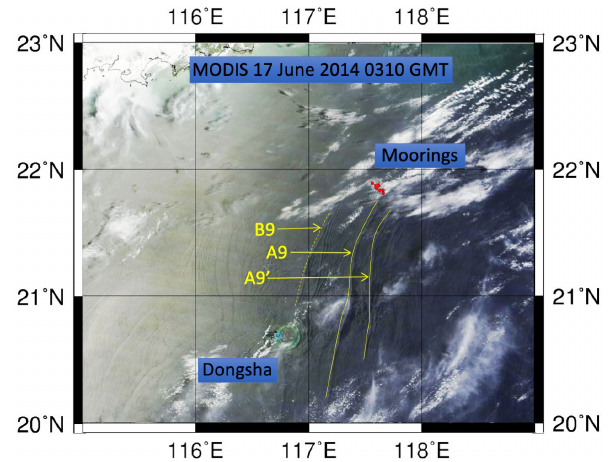
Figure 9. A sea surface ocean color image obtained at 03:10 on 17 June 2014 from the Moderate Resolution Imaging Spectrora- diometer (MODIS). The sand dunes moorings are indicated by the red dots. The surface signatures of NLIWs B9, A9, and A9’ are indi- cated by the yellow arrows. Wave A9 was impinging upon mooring YPO2 at this moment, as seen in Fig. 7 (base image data courtesy of NASA, plotted using HDFLook and GMT